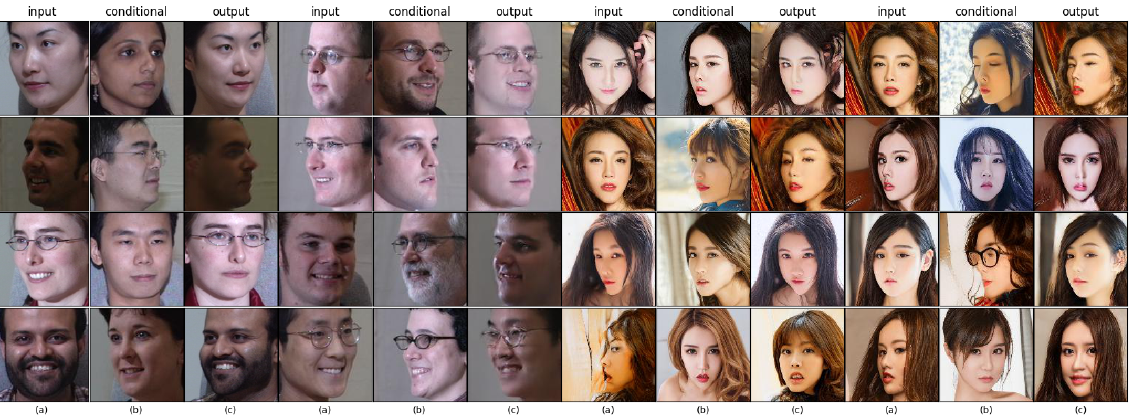
Figure 3. Experimental results from two datasets under source face and conditional face have larger differences in shape and size. ( a ) Source faces (128 × 128 pixels). ( b ) Conditional faces. ( c ) Transfer results by